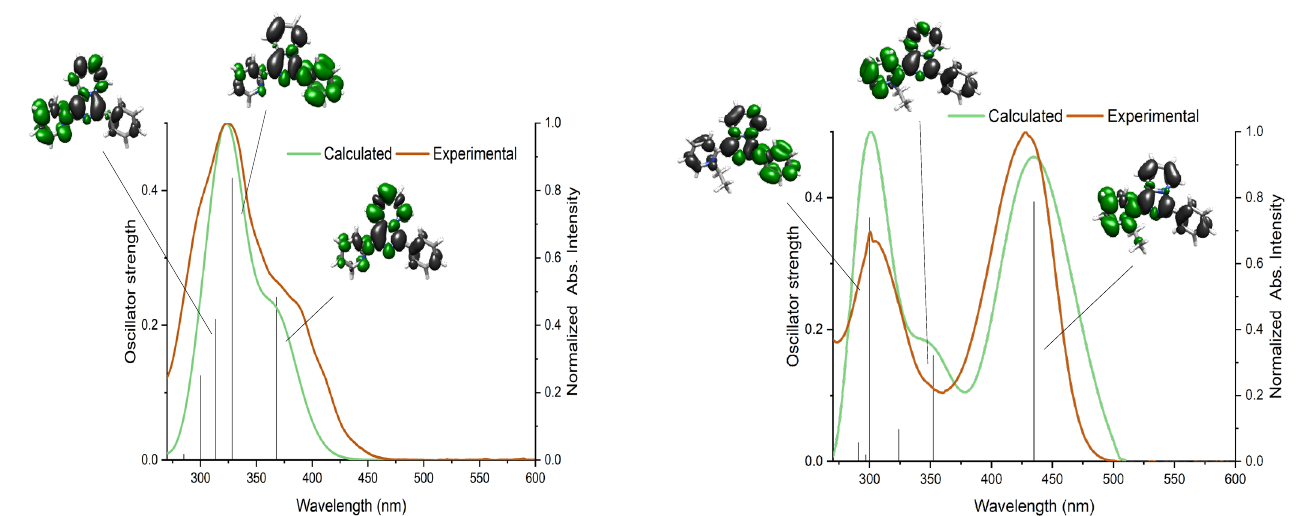
Figure 4. Experimental (orange) and calculated (green) absorption spectra of 1 ( left ) and 1q ( right ). The Electron Density Difference Maps (EDDMs) of the most relevant transitions are shown.